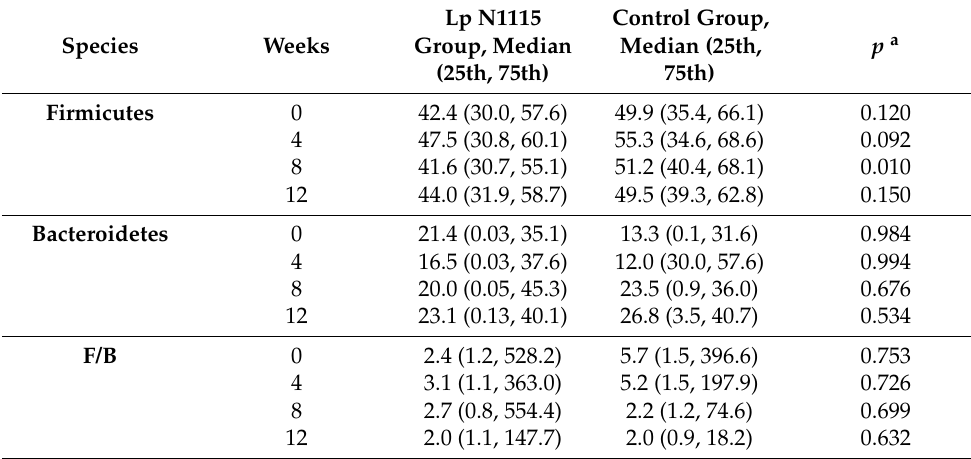
Table 2. The relative abundance and ratio (F/B) of Firmicutes and Bacteroidetes.